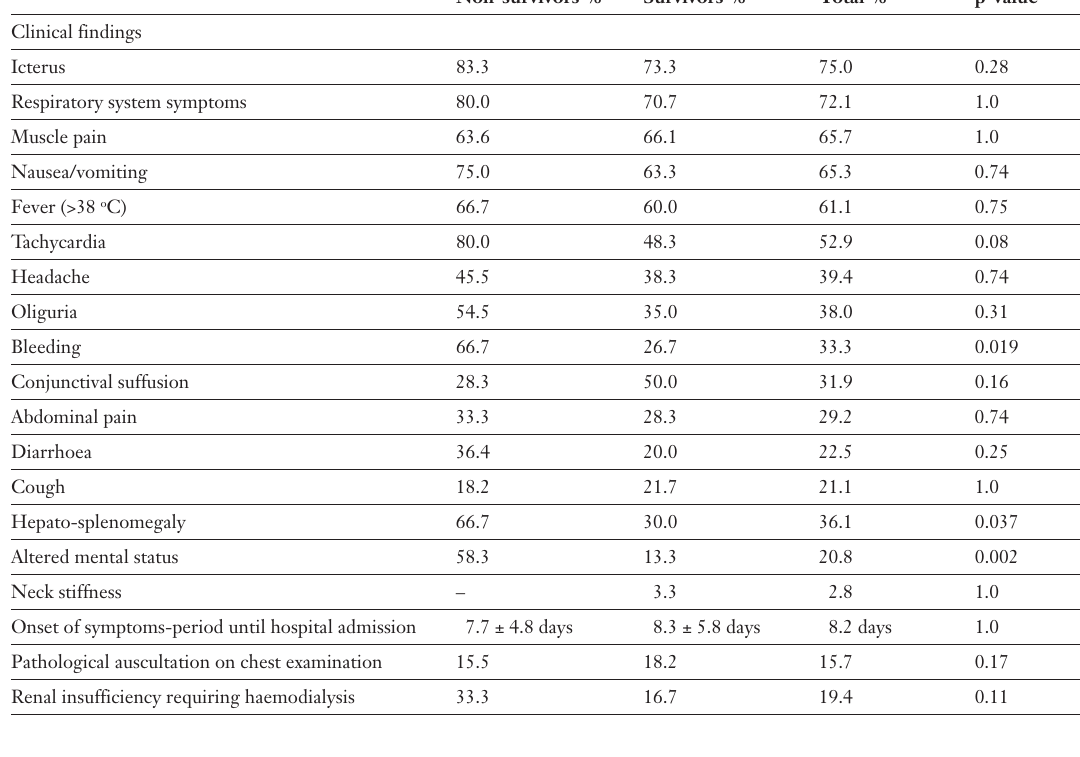
Laboratory test re- sults.